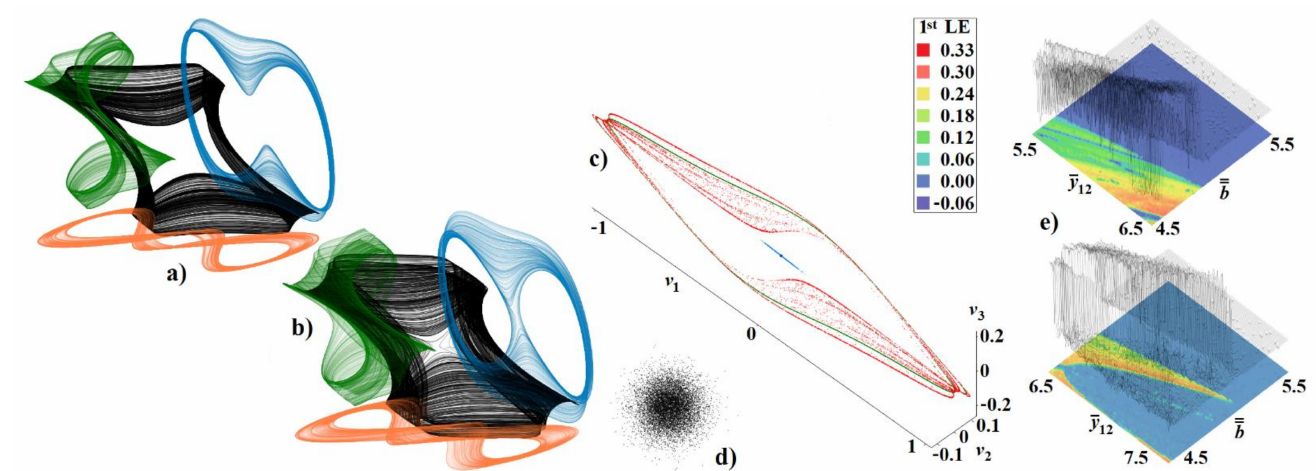
Figure 12. Resonant amplifier with Darlington-type topology, third order autonomous dynamical system is considered for analysis. Perspective 3D views (black trajectory) on the typical strange attractor including individual plane projections (orange color for v 1 vs. v 2 , blue color denotes v 1 = 6 S, ( b ) y = 6.7 S, ( c ) sensitivity of system vs. v 3 and green color marks v 2 vs. v 3 ) for: ( a ) y 12 12 solution to the changes of the initial conditions, ( d ) group of 10 4 initial conditions generated by following the normal distribution, ( e ) rainbow-scaled contour-surface plot of the largest LE calculated for parameter range and color legend